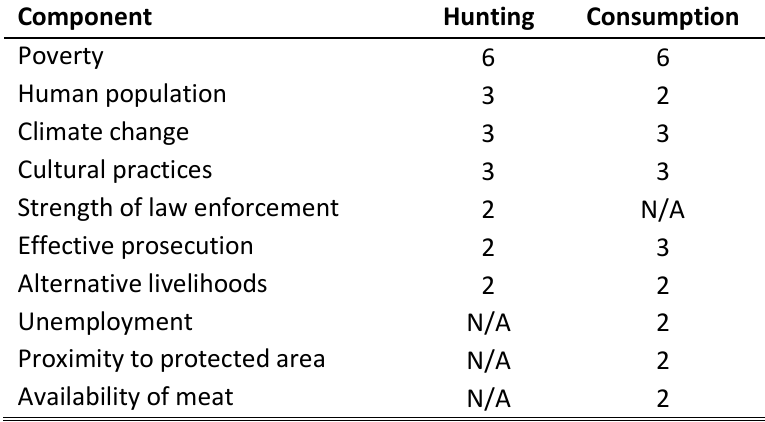
Table A 1.1: The number of times that a component was listed by different individuals for hunting and consumption maps at the pre-workshop